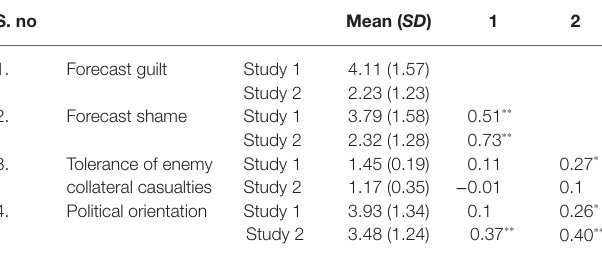
TABLE 1 | Means, standard deviations and zero-order correlations between variables (studies